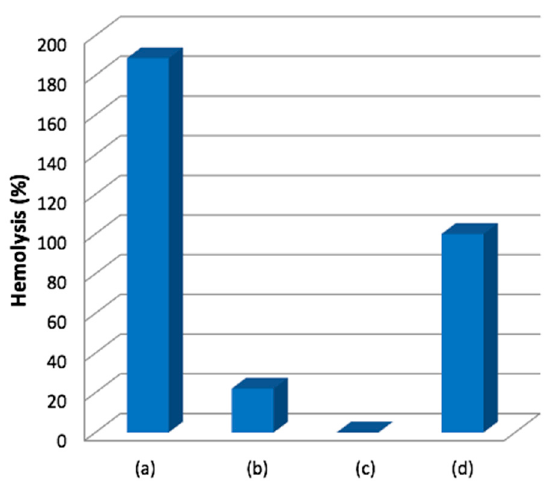
Figure 4. Comparison of hemolytic activity (%) to: ( a ) methylene blue (MB), ( b ) yeast extracts obtained from MB removal tests, ( c ) negative control (phosphate-buffer-treated erythrocytes, PBS) and ( d ) positive control (Triton-X-100) .